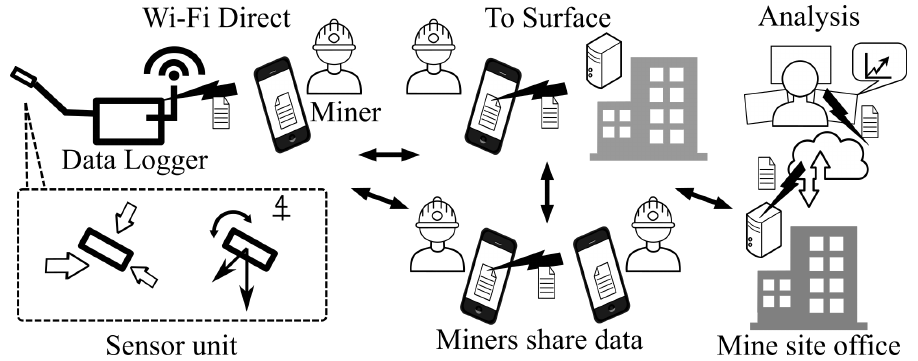
Figure 1. The data transmission monitoring system